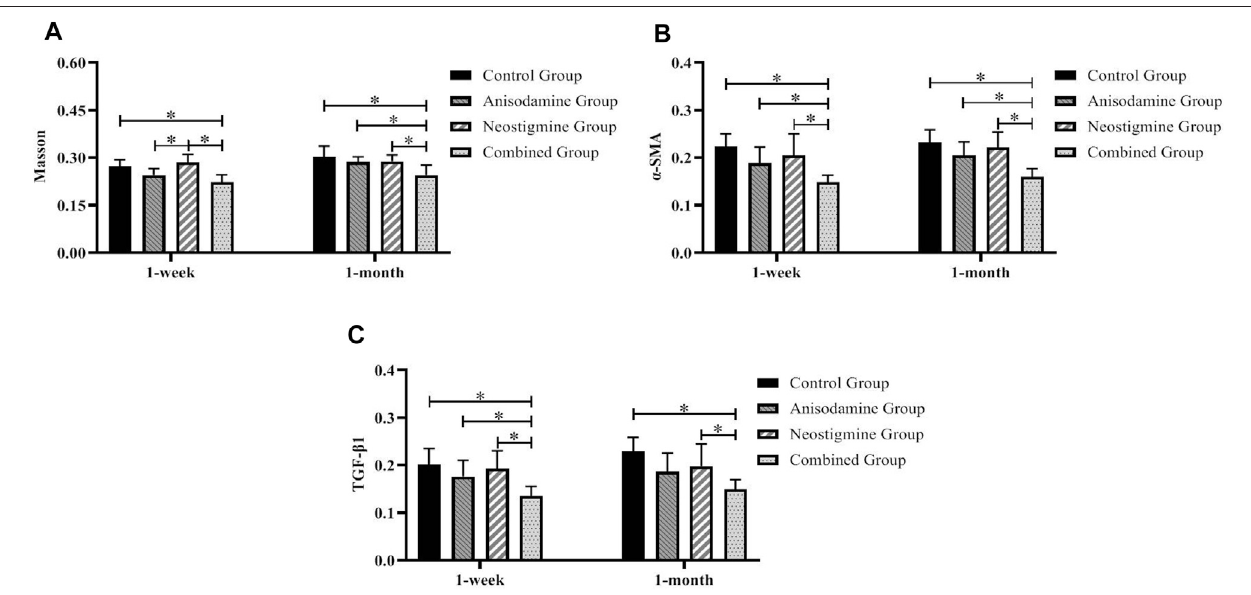
FIGURE8| ComparisonofthepathologicalstainingMODofanastomoticstomainratsatdifferenttimepointsaftertheRCJSprocedure(*referstothecomparison between the two groups, p < 0.05). Comparison of MOD values of (A) Masson ’ s staining, (B) α -SMA immunohistochemical staining, and (C) TGF- β 1 immunohistochemical staining at different time points in rats of each